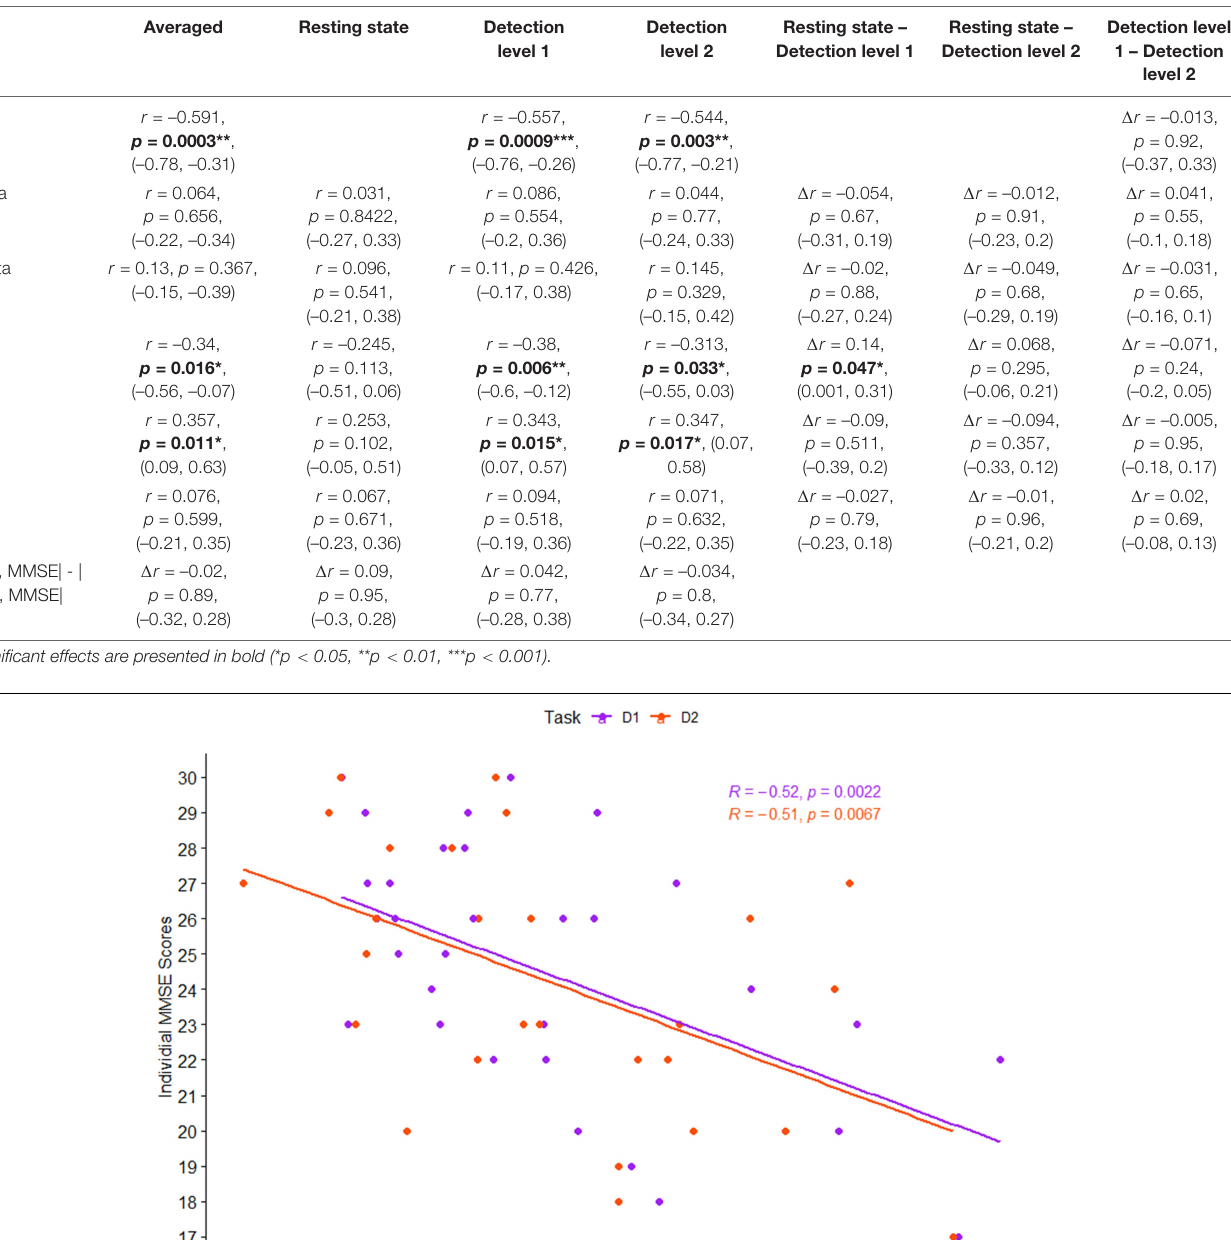
TABLE 2 | Pearson r coefficients (first row of each cell), p -values (second row), and 95% CI (third row) of the correlations between individual MMSE scores and EEG features (and reaction times) as a function of task (averaged across tasks, resting state, detection level 1, and detection level 2); and the difference between correlation coefficients and CIs between tasks, as calculated by Meng et al. (1992) z extension of the Fisher Z transform (Dunn and Clark, 1969), including a test of the confidence interval for comparing two correlations.